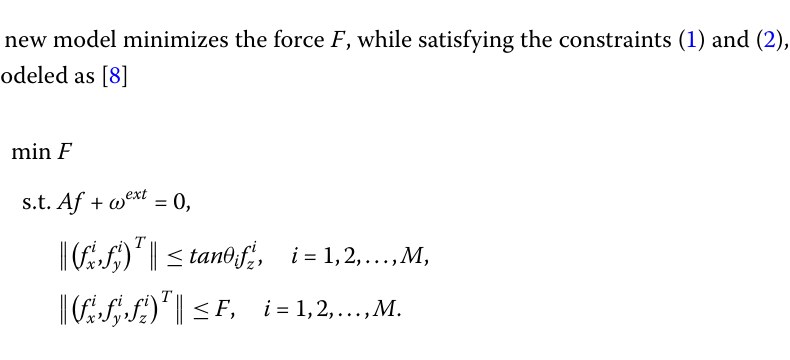
Table 2 The test results for the min-max force-optimization problems of Example 5.2 Methods 4000 2000 Iter. Time Iter. Time IMBADM 223 0.223 223